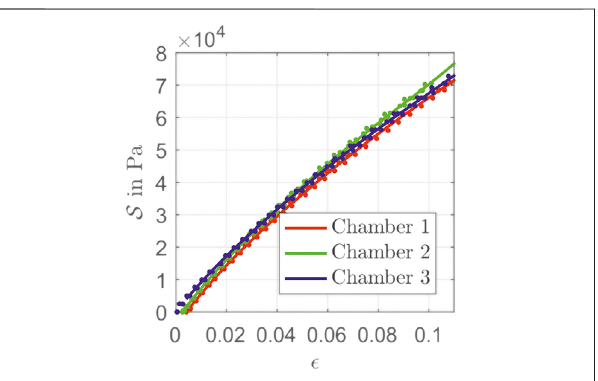
FIGURE 4 | Identi fi ed stiffness parameters of the actuator